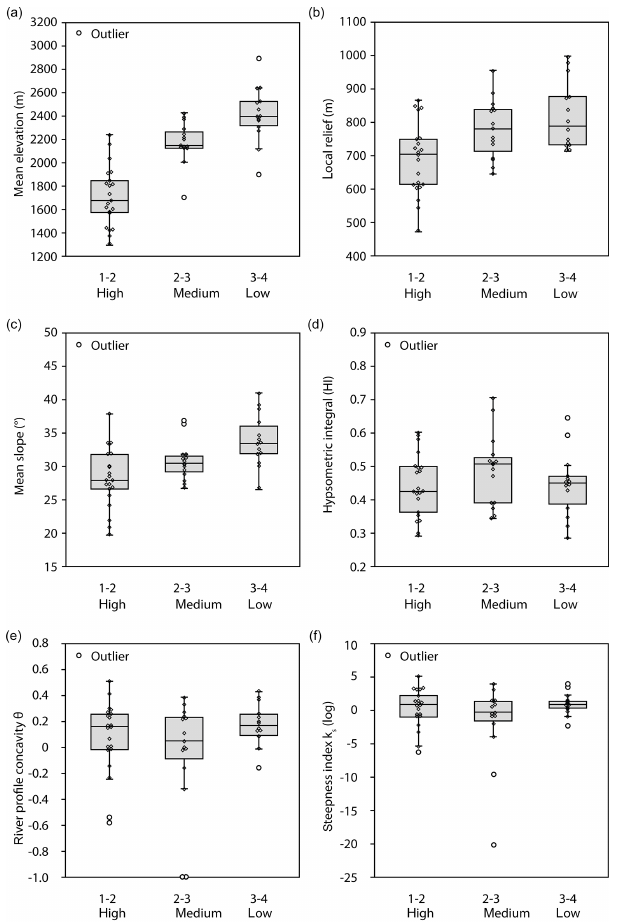
Figure 13. Boxplots of the topographic variables grouped accord- ing to erodibility.